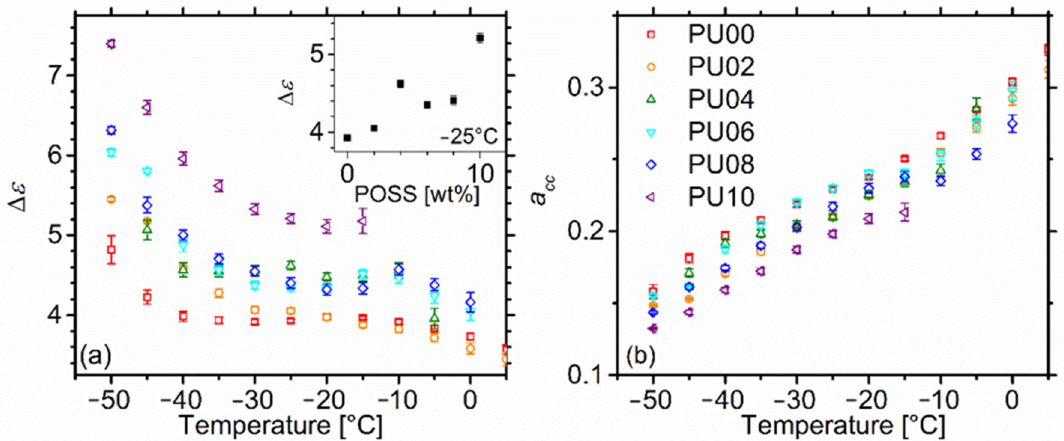
Figure 12. Dependence of ( a ) ∆ ε and ( b ) shape exponent a of α relaxation as a function of temperature. The onset of ( a ) shows the dependence of ∆ ε at − 25 ◦ C on POSS content.